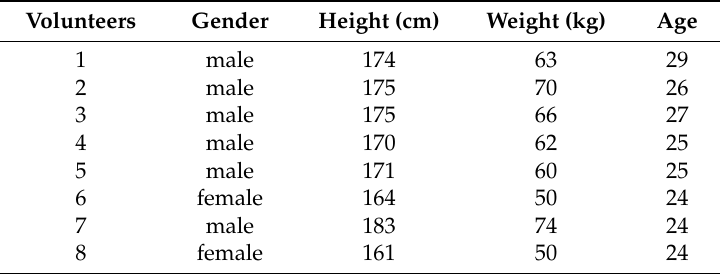
Figure 6. Experimental scenario. Table 2. Basic information of volunteers